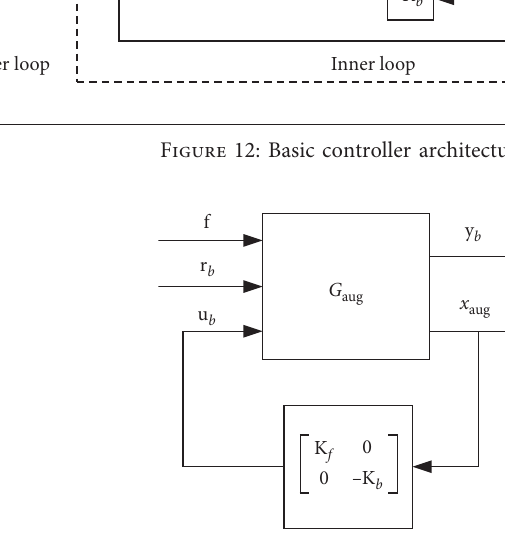
Figure 13: Standard structure of H-infinity